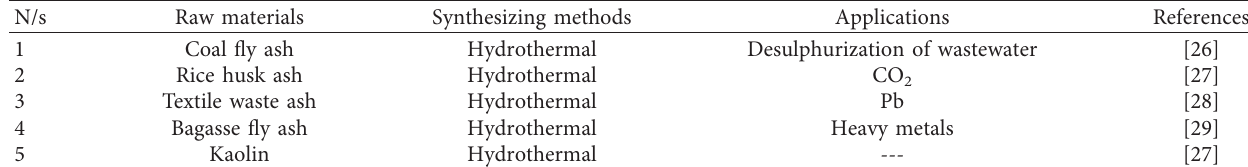
Table 1: The lists of raw materials and synthesizing methods of